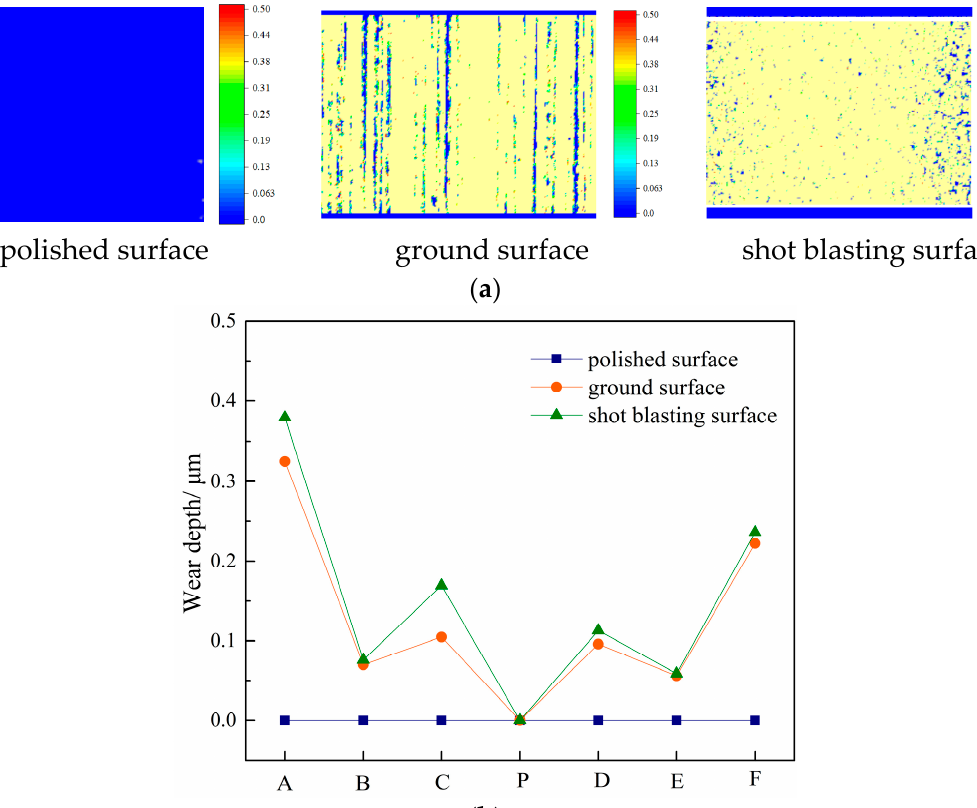
Figure 13. Wear levels of different machined surfaces. ( a ) Wear distribution. ( b ) Wear depth.